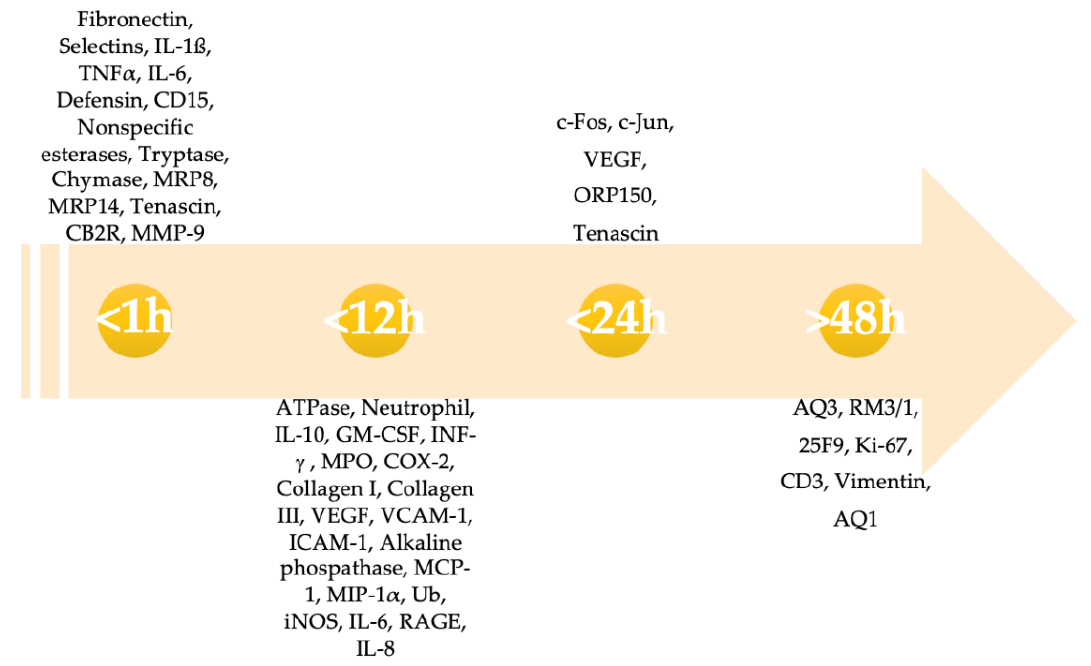
Figure 2. The timing of positivity of several immunohistochemical vitality markers after wounding. This figure includes exclusively markers for the skin. GM-CSF, granulocyte macrophage-colony stimulating factor; ICAM-1, intercellular adhesion molecule 1; IL, interleukin; iNOS, inducible nitric oxide synthase; MCP, monocyte chemoattractant protein; MMP, matrix metallopeptidase; RAGE, receptor for advanced glycation endproducts; TNF- α, tumor necrosis factor α; VEGF, vascular endothelial growth factor; VCAM-1, vascular cell adhesion molecule-1. Table 4. This table shows the timing of positivity of immunohistoichemical vitality markers in dif- ferent tissues after wounding. IL, interleuk in; α7nAChR, α7 nicotine acetylcholine receptor; A1 - ACT, alpha1-antichymotrypsin; RM3/1, anti-CD163 marker; 25F9, mature macrophages marker; GM-CSF, granulocyte macrophage-colony stimulating factor; GPA, glycophorin A; HSP, heat-shock protein; ICAM-1, intercellular adhesion molecule 1; iNOS, inducible nitric oxide synthase; mAb, monoclonal antibody; MCP, monocyte chemoattractant protein; MHC-II, major histocompatibility complex II; MMP, matrix metallopeptidase; RAGE, receptor for advanced glycation endproducts; TNF- α, tumor necrosis factor α; VEGF, vascular endothelial growth factor; VCAM -1, vascular cell adhesion molecule-1; ATP, adenosine triphosphate; MRP, myeloid-related protein; M-CSF, macro- phage colony-stimulating factor; MIG, monokine inducible by interferon gamma; ORP, oxygen reg- ulated protein; HLA, human leukocyte antigen; TGF, transforming growth factor; MPO, myelop- eroxidases; COX, cyclooxygenase; CB2R, cannabinoid receptor type 2; SP, surfactant protein; HIF, hypoxia inducible factor; AQ, aquaporin; MIP, macrophage inflammatory protein; CML, carbox- ymethyllysine; Flk, receptor for vascular growth factor; EPC, endothelial progenitor cell; TIMP, met- allopeptidase inhibitor; Chil, chitinase-like; INF, interferon; Ub, ubiquitin.